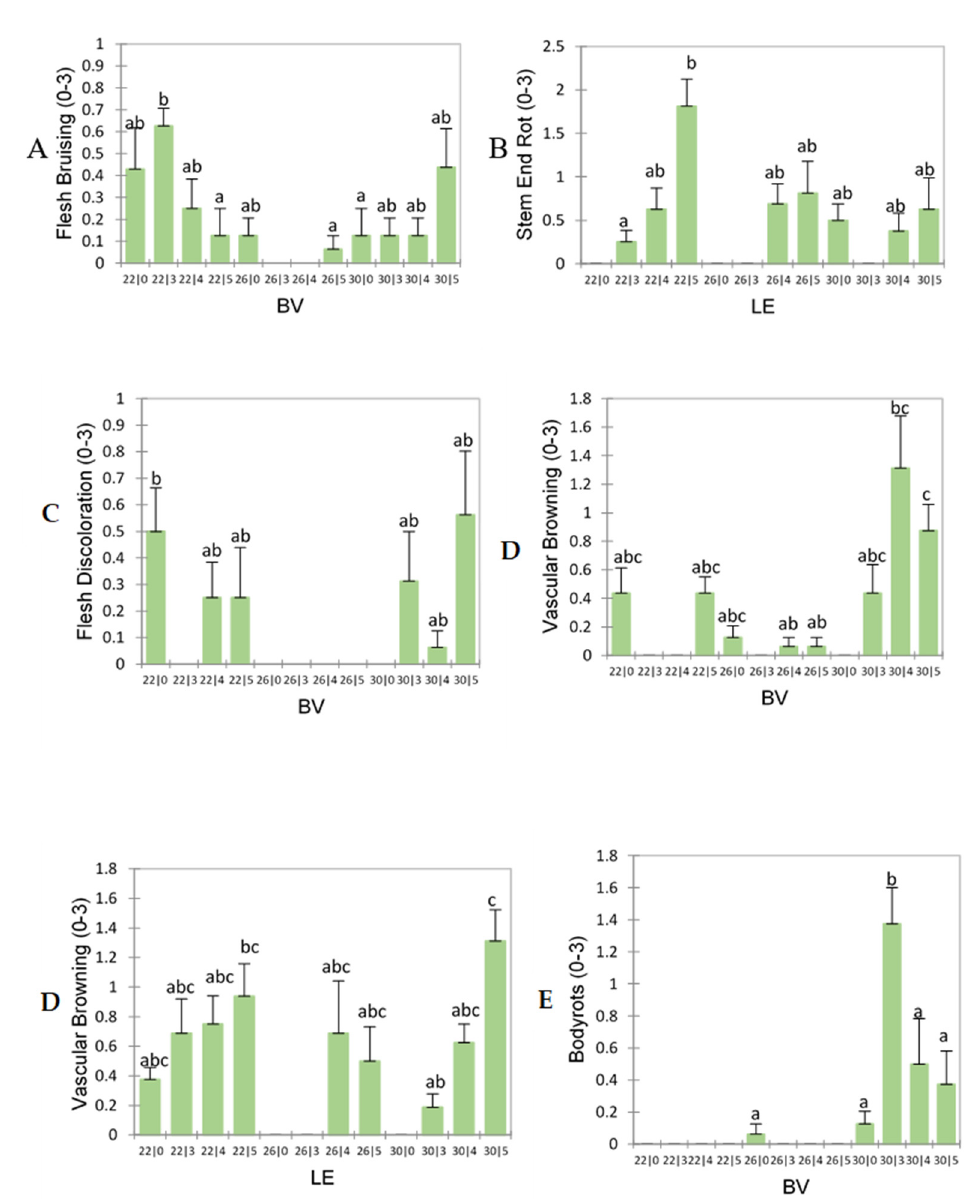
Figure 2. Fruit internal disorders (only orchards that had significant results are shown, mean ± standard error): flesh bruising ( A ), stem end rot ( B ), flesh discoloration ( C ), vascular browning ( D ), and body rots ( E ) .